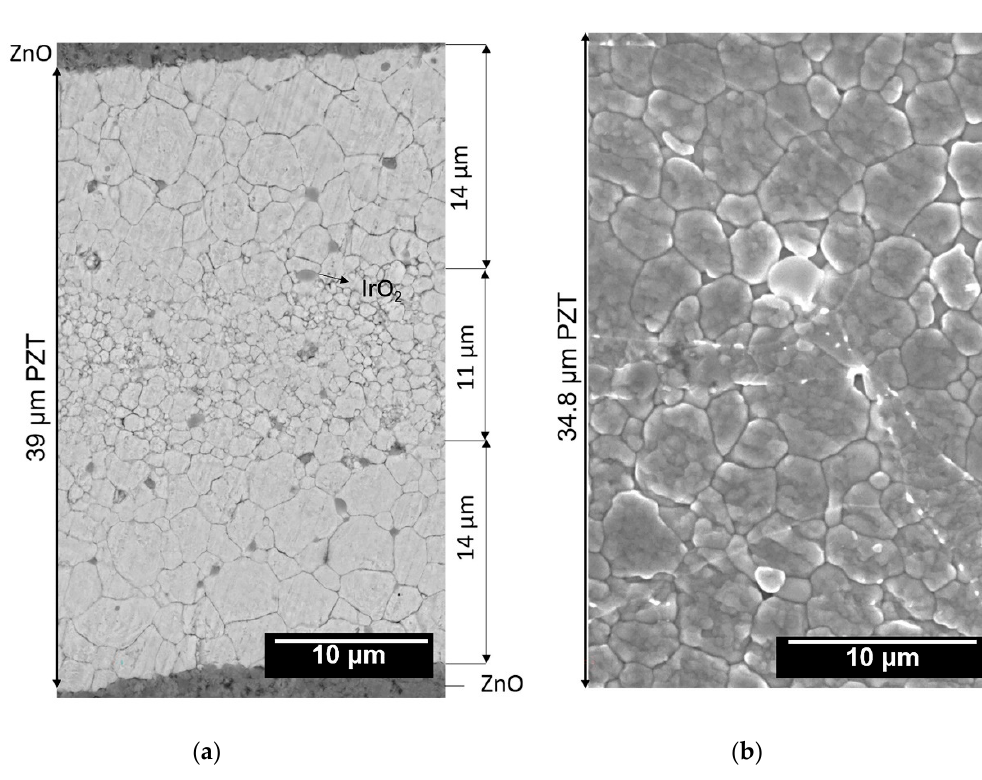
Figure 6. SEM microstructures of polished cross sections of the PZT layers in ( a ) 16 element and ( b ) 32 element composites: ( a ) 39 μ m thick PZT beam; ( b ) 34.8 μ m thick PZT beam. The samples were coated with iridium prior to imaging. The dark grains in the PZT beam in ( a ) are oxidized IrO 2 .